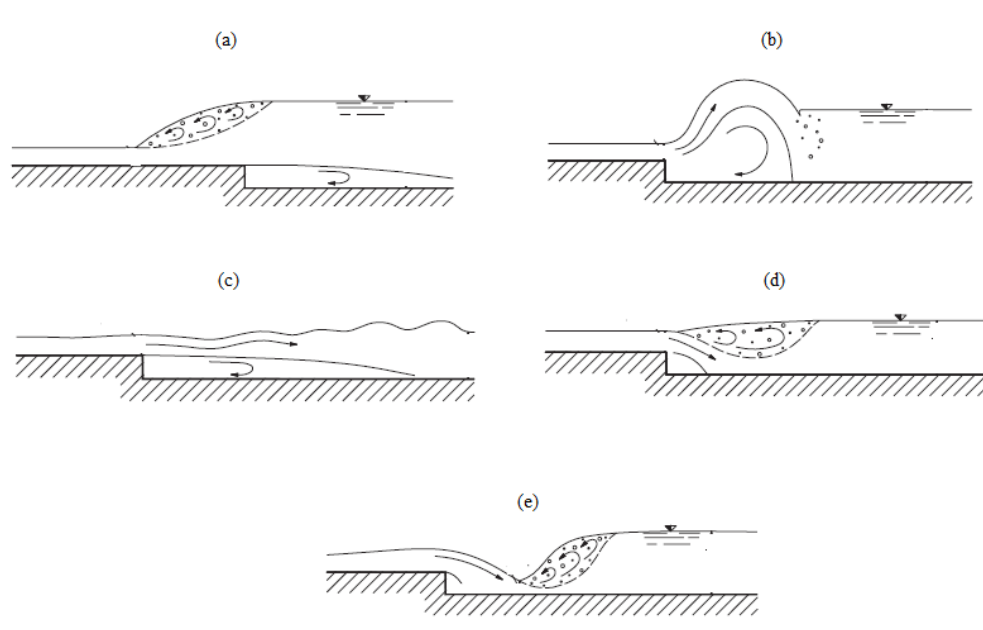
Figure 1. Flow conditions (from Ohtsu and Yasuda, 1991): ( a ) A-jump; ( b ) wave jump; ( c ) wave train; ( d ) B-jump (maximum plunging condition); and ( e ) minimum B-jump (limited jump).